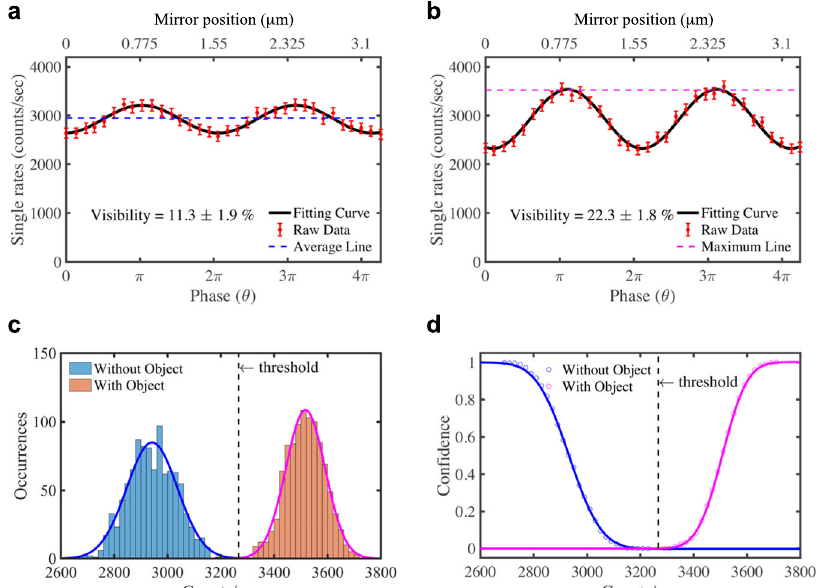
Fig. 2 Interaction-free quantum sensing with undetected photons. a By adjusting the phase θ of the signal photons, we obtain the residual interference of the signal photon in the absence of the object with a visibility of 11.3 ± 1.9%. b When the object is present, the idler photon performs a successful IFM and induces the interference of the signal photon. The experimental visibility is 22.3 ± 1.8%. The relative phase θ can be tuned by adjusting optical path difference of two arms in the nonlinear interferometer with motorized translation stages mounted on the mirrors R 1 . c Counting histogram of the signal photon fi tted by two Gaussian distributions. The width of each bin is 20 counts per second. The mean counts per second for sensing the presence (purple) and absence (blue) of the object are about 3,500 and 2,950, respectively. By setting a threshold (vertical black dash line), we clearly distinguish whether the object is present or not. d The con fi dence of the sensing is obtained by integrating the two Gaussian distributions shown in panel ( c ); a con fi dence level above 99.93% at the 3.4-sigma threshold is obtained. Error bars in panels ( a and b ) indicate two standard errors of the